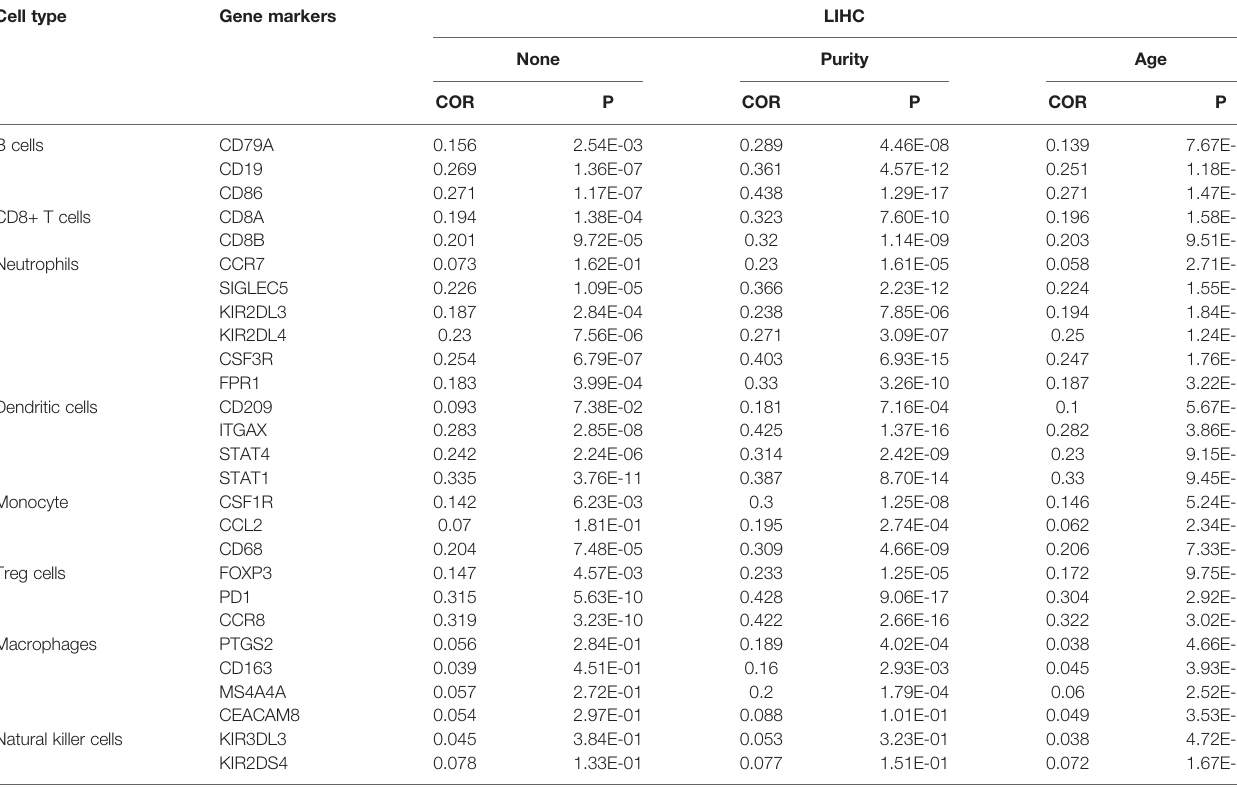
TABLE 1 | Correlation analysis between ASF1B and immune cell type markers in TIMER database. Cell type Gene